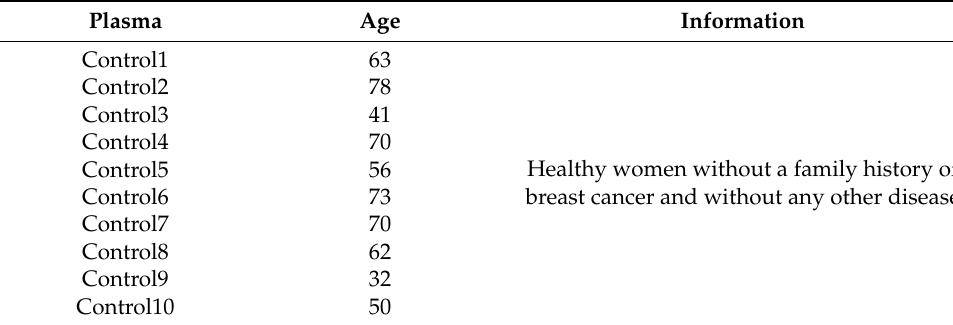
Table 4. Data of women used as a control